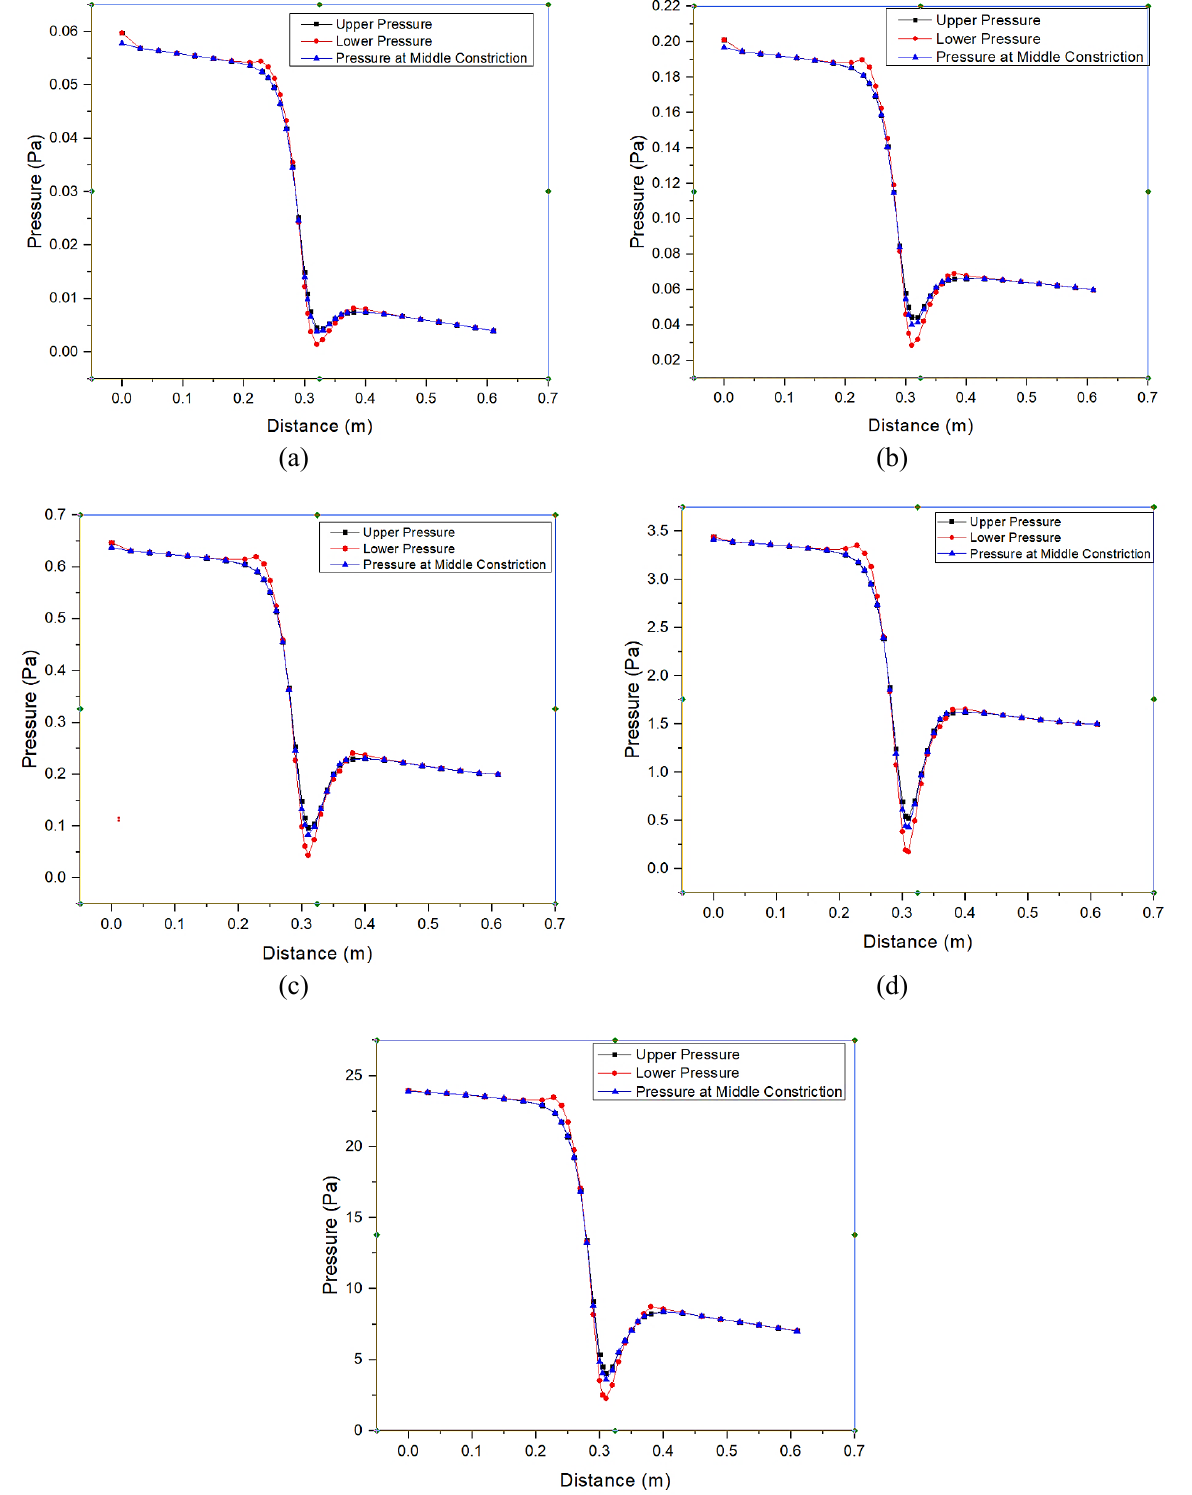
Fig. 3. Effect of fluid flow on Pressure (a) Re=100 (b)Re=200 (c) Re=400 (d) Re=1000 (e) Re=